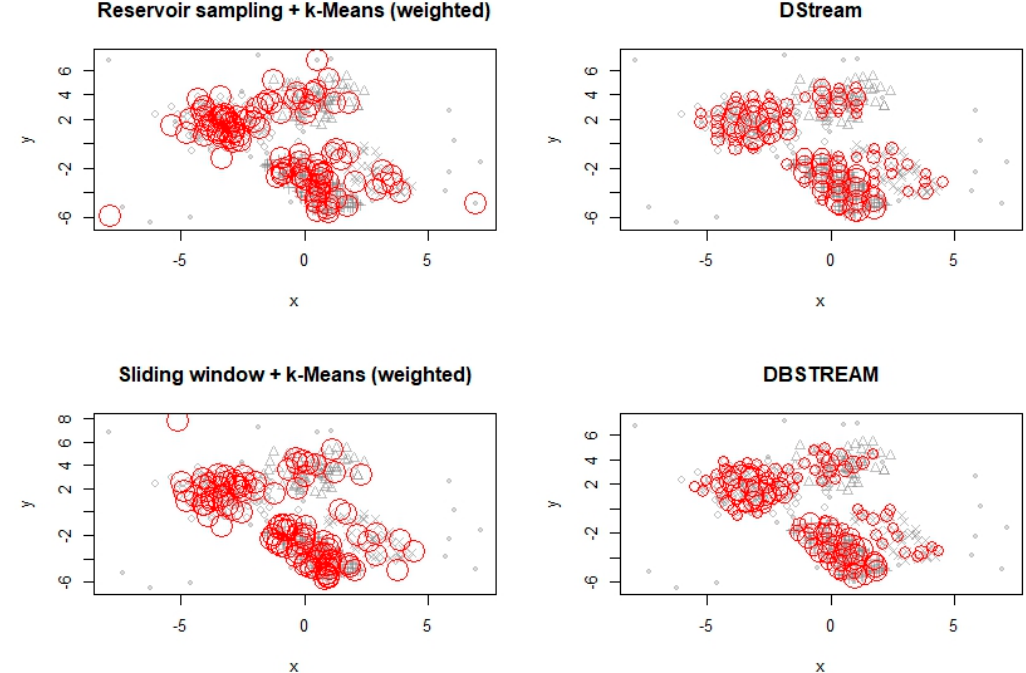
Figure 3. Micro-cluster placement for different data stream clustering algorithms.